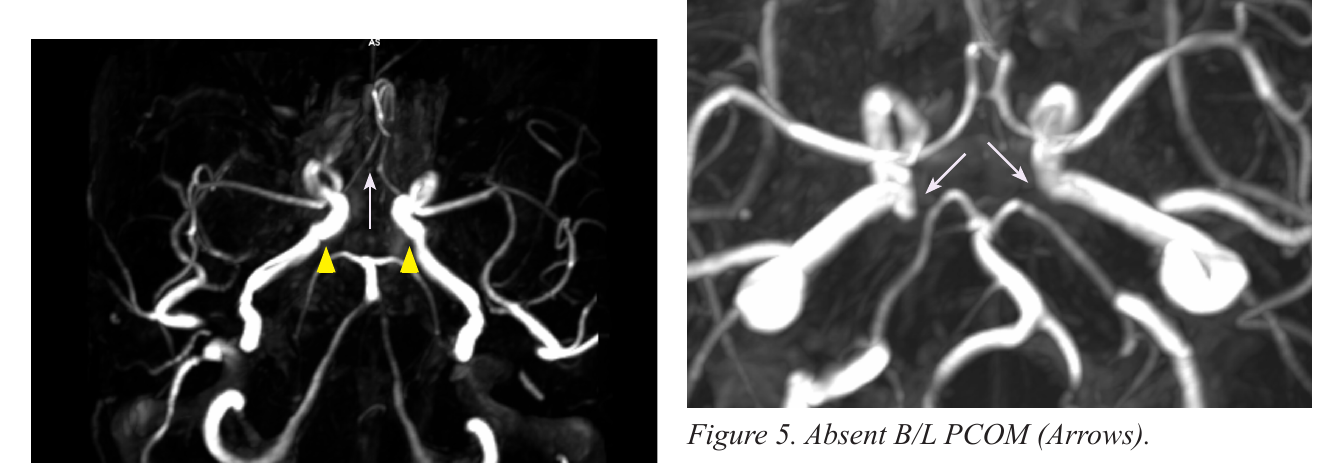
Figure 1. Normal COW.